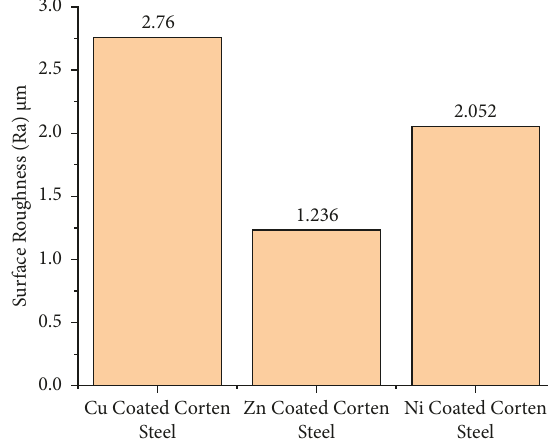
Figure 4: Coating thickness of electroplated corten steel.